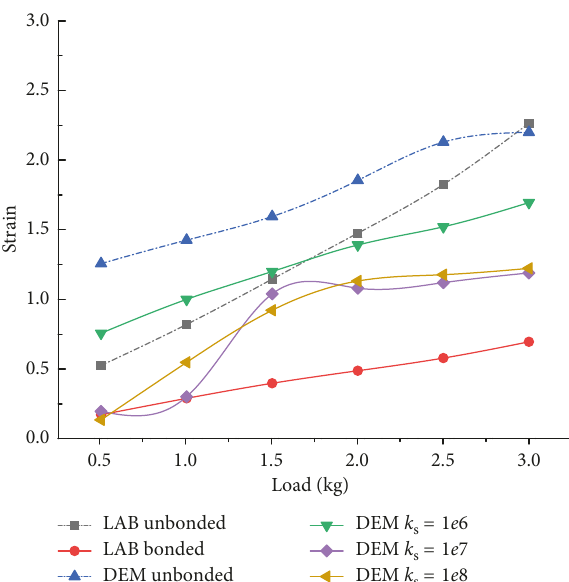
Figure 15: Comparison of effective contact numbers between photoelastic mode test and DEM